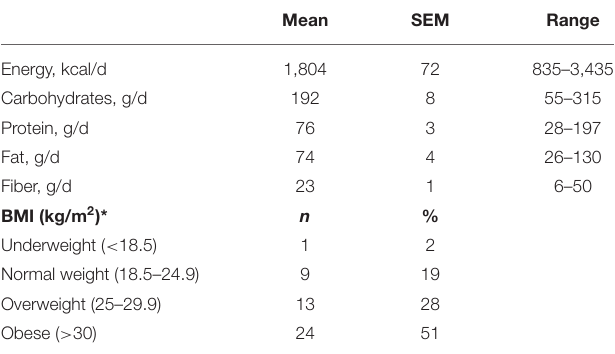
TABLE 6 | Baseline nutritional data and Body Mass Index from 47 of the participants, calculated from the first